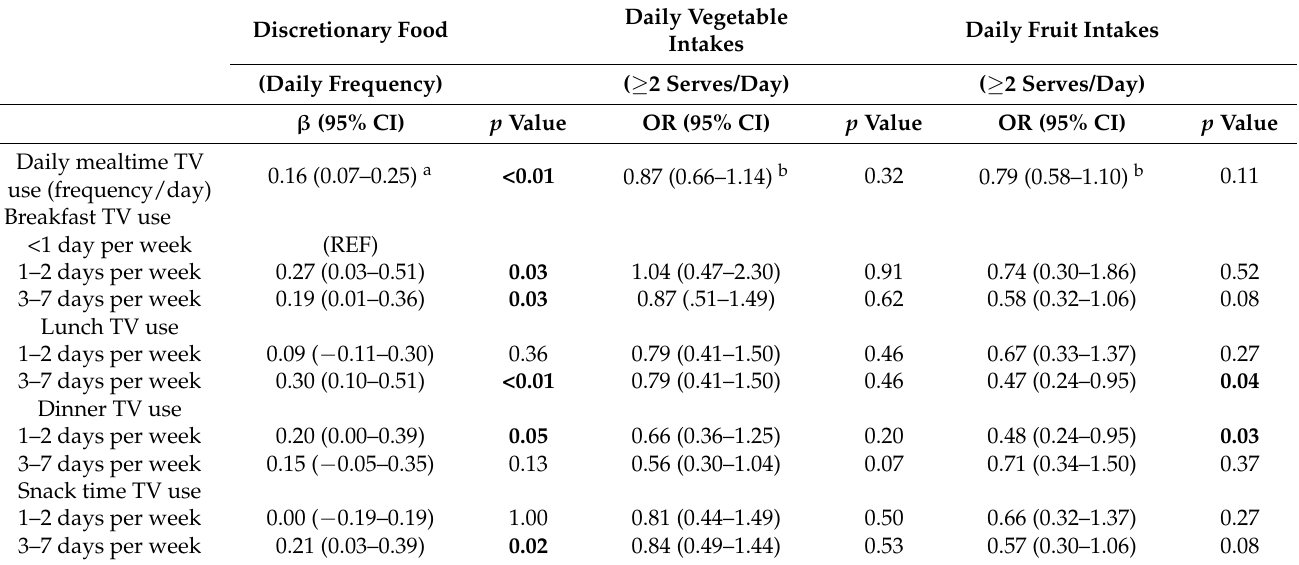
Table 2. Crude model. Association between children’s mealtime TV use at baseline and consuming two or more serves of fruit and vegetables per day, and consuming non-core discretionary foods on more than one occasion per day at the follow-up, adjusting for baseline intakes.